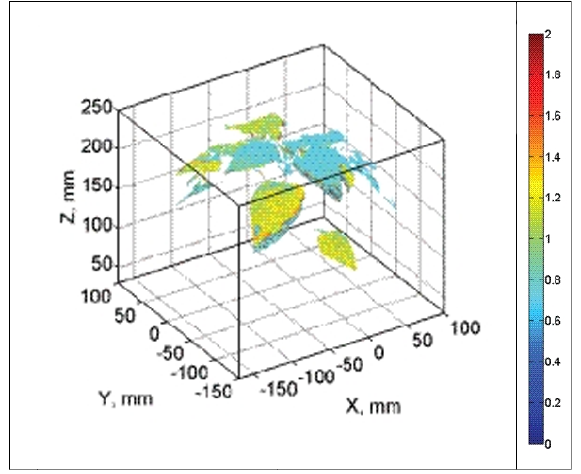
Figure 9. Distribution of Rfd100 parameter over water stressed pepper plants cultivated for five days in low light conditions (LS: 85 μ mol (photons) m − 2 ·s − 1 , 30% pot water capacity). Rfd100 parameters were measured by projection of chlorophyll fluorescence emission on 3D computer reconstruction of plants.